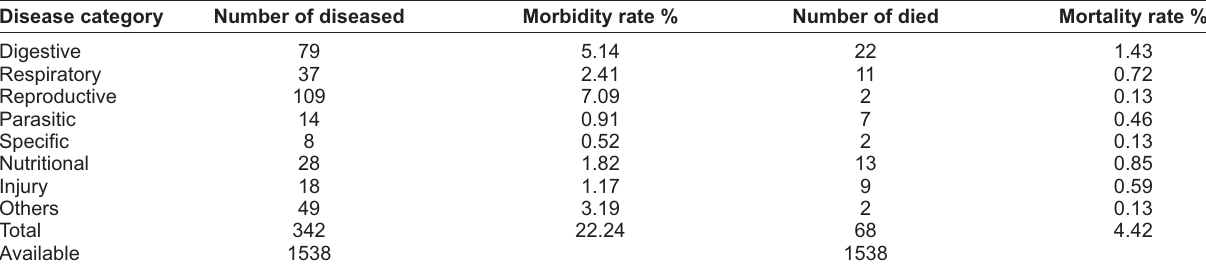
Table-2. Overall disease rates in cattle during study